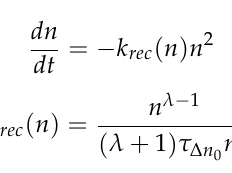
Figure 7. Recombination coefficient, K rec , as a function of charge